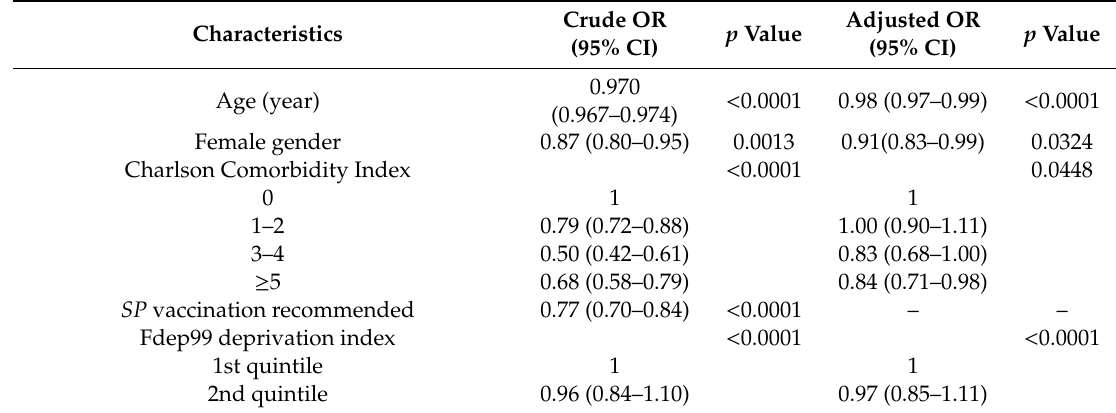
Table 5. Logistic regression model for factors associated with vaccination against SP or Hib during the study period—secondary